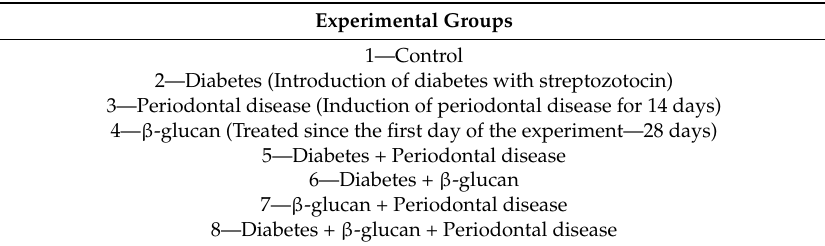
Table 1. Distribution of experimental